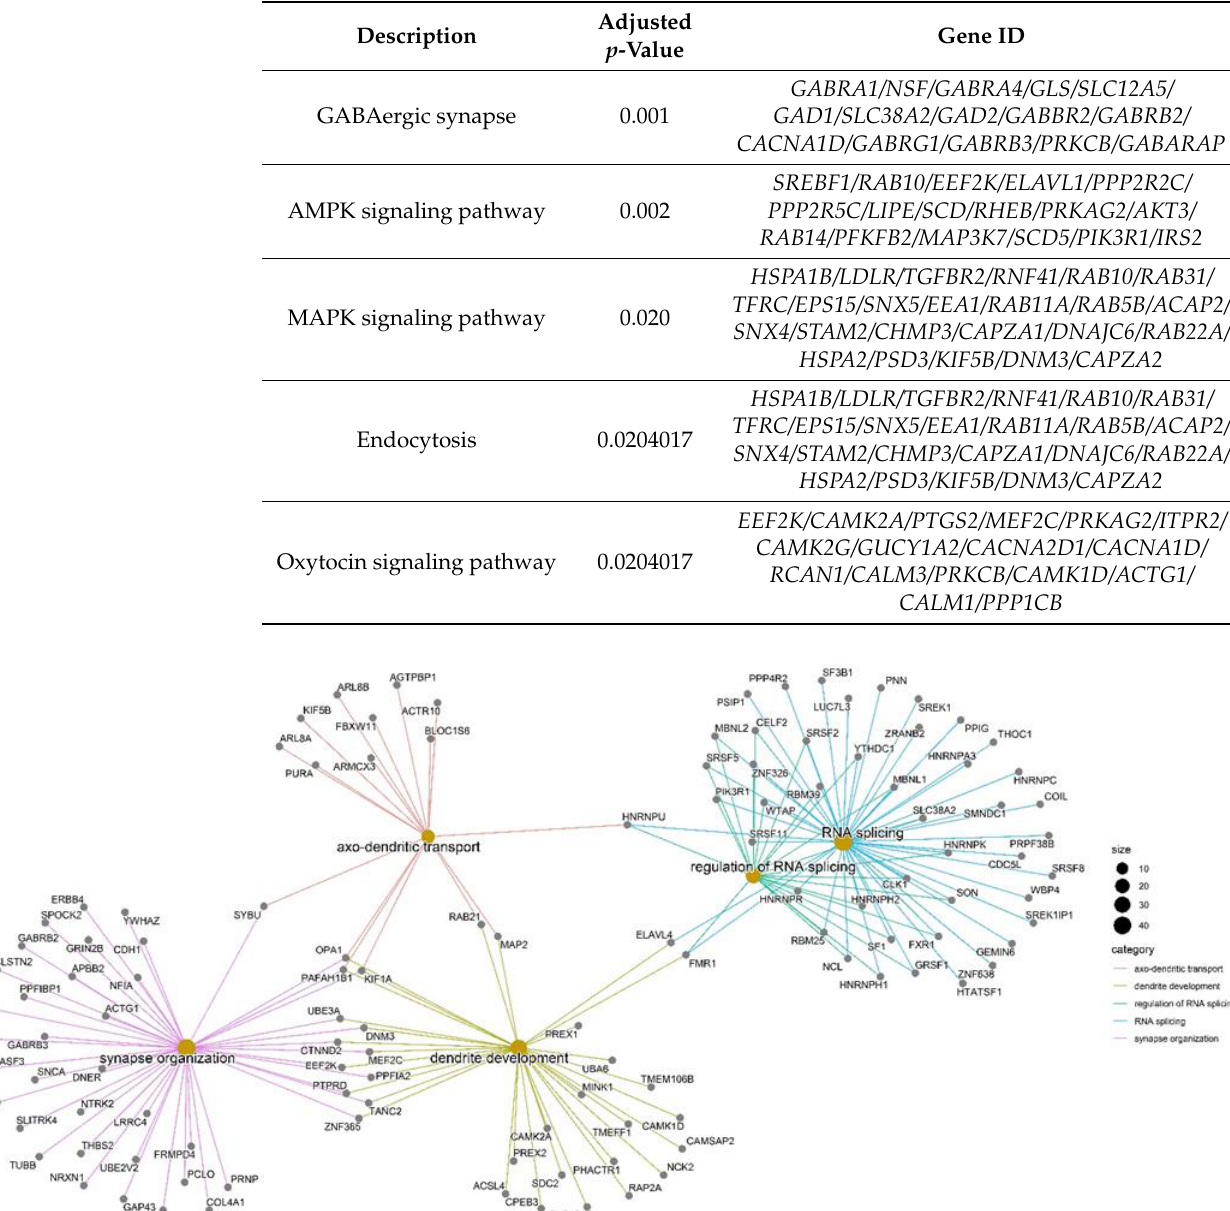
Figure 2. Gene-concept networks from the KEGG enrichment analysis; the beige circles represent pathways while the gray ovals indicate genes.